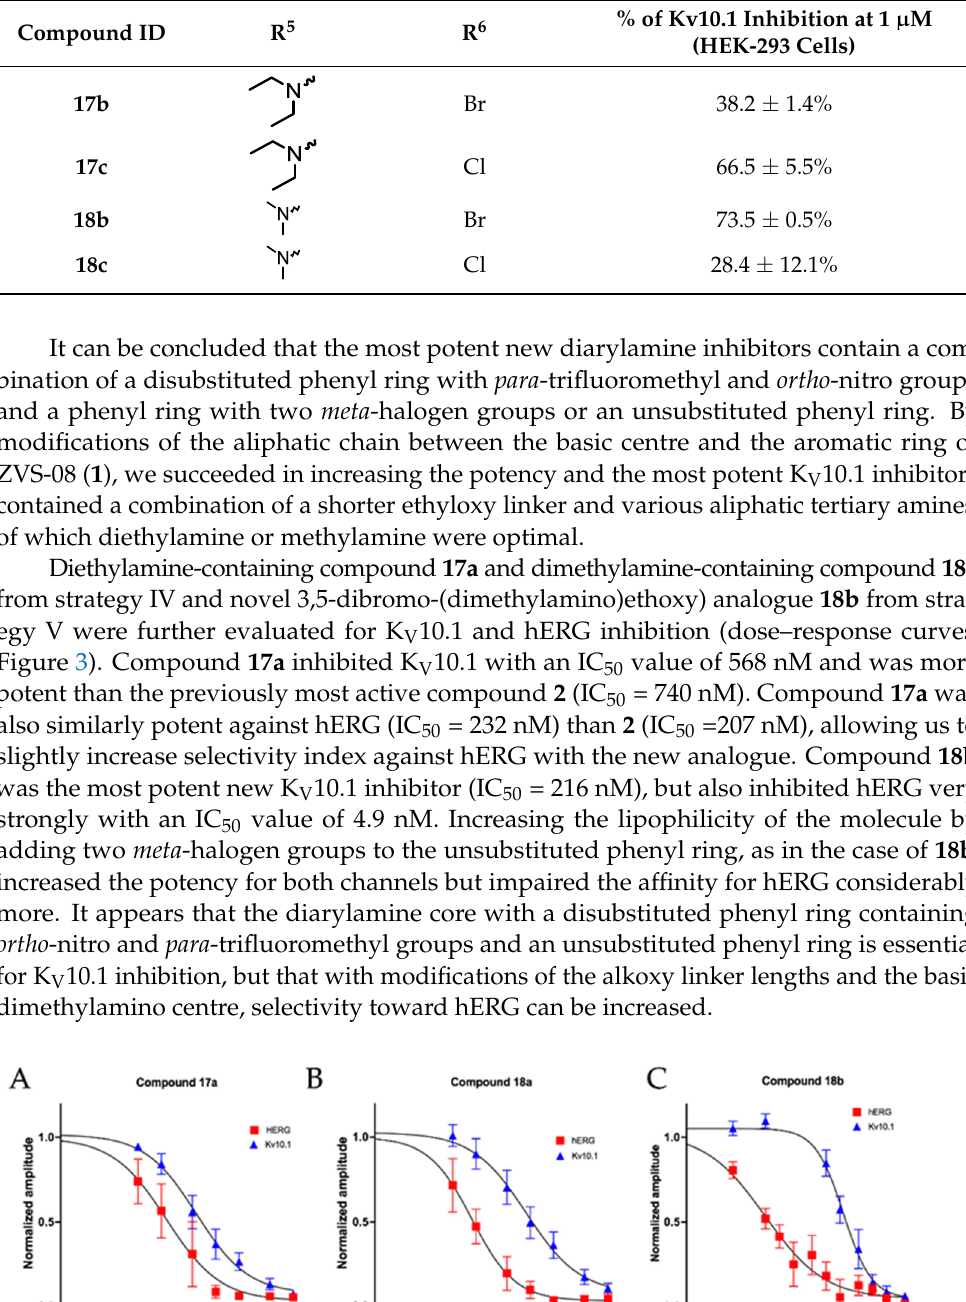
compound 18a for K V 10.1 (blue) and hERG (red) inhibition. The IC 50 values from the fit